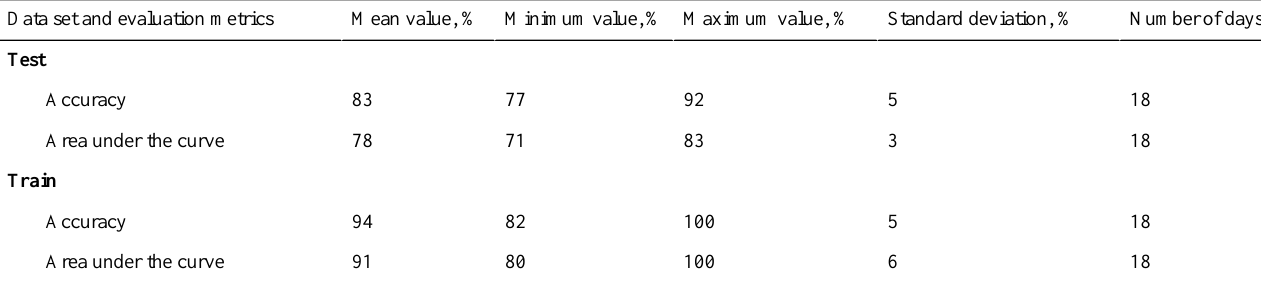
Table 1. XGBoost classification training and testing details.